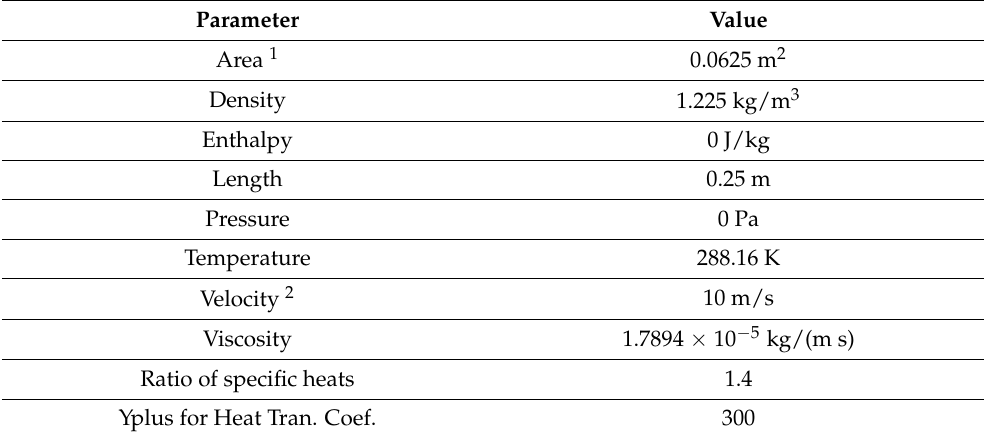
Table 1. Reference values for single blade simulation.